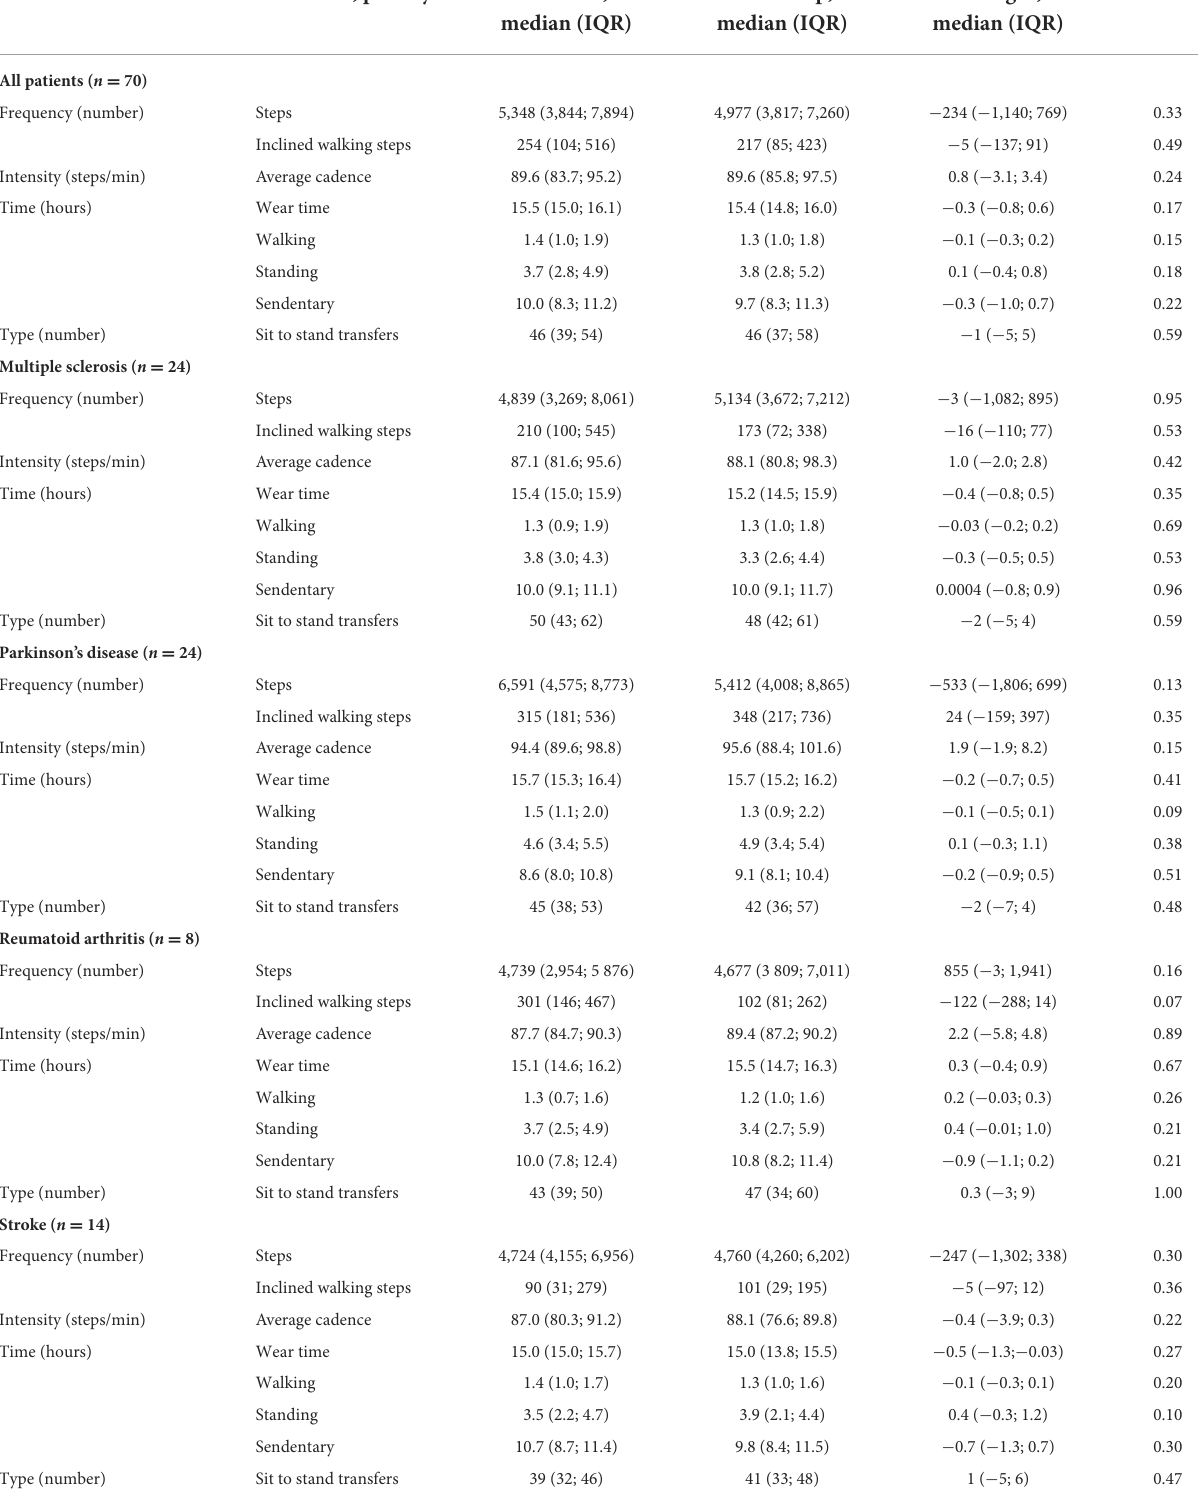
TABLE 3 Physical activity per day of patients with the four chronic diseases described by the dimensions of frequency, intensity, time, and type.